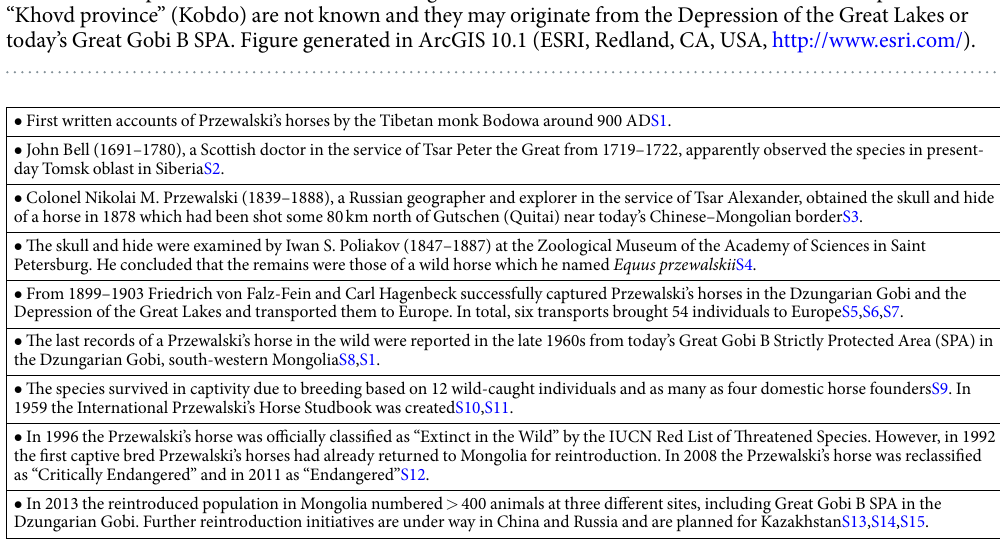
Table 1. Timeline for Przewalski’s horses - discovery, extinction in the wild, and reintroduction. For references see Supplementary Information